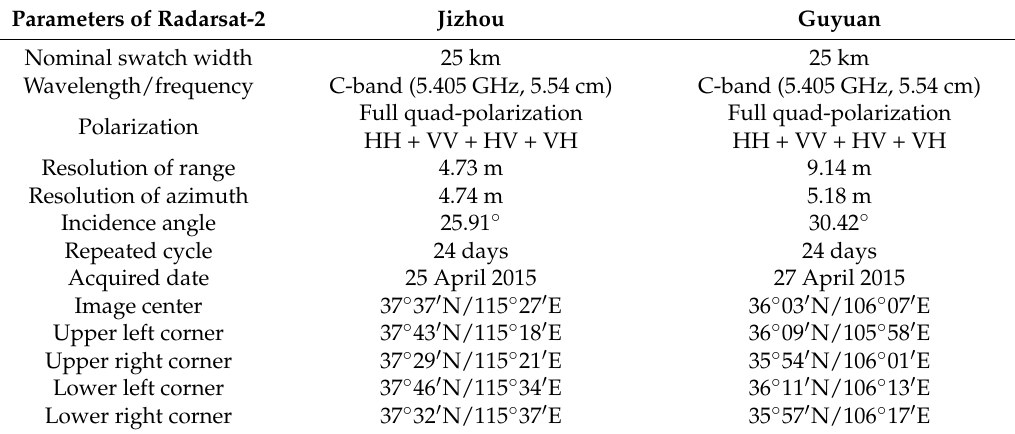
Table 1. Parameters of Radarsat-2 satellite data in Jizhou and Guyuan Parameters of Radarsat-2